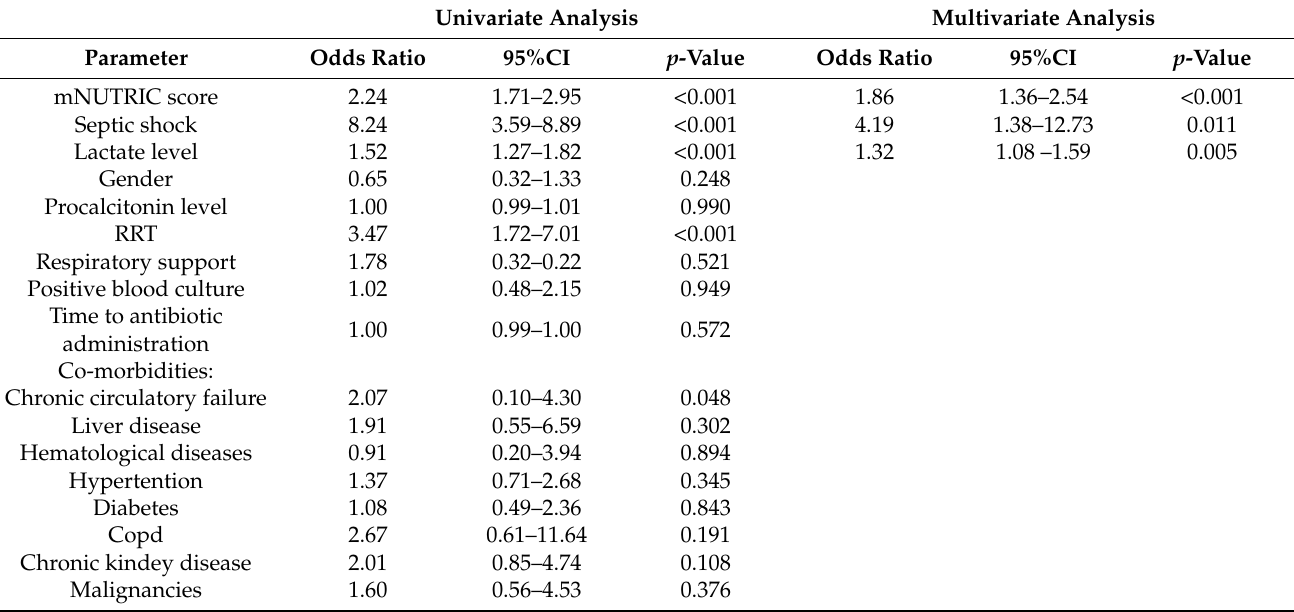
Table 5. Univariate and multivariate logistic regression analysis of the predictors of 28-day mortal- ity. All parameters refer to the day of ICU admission.